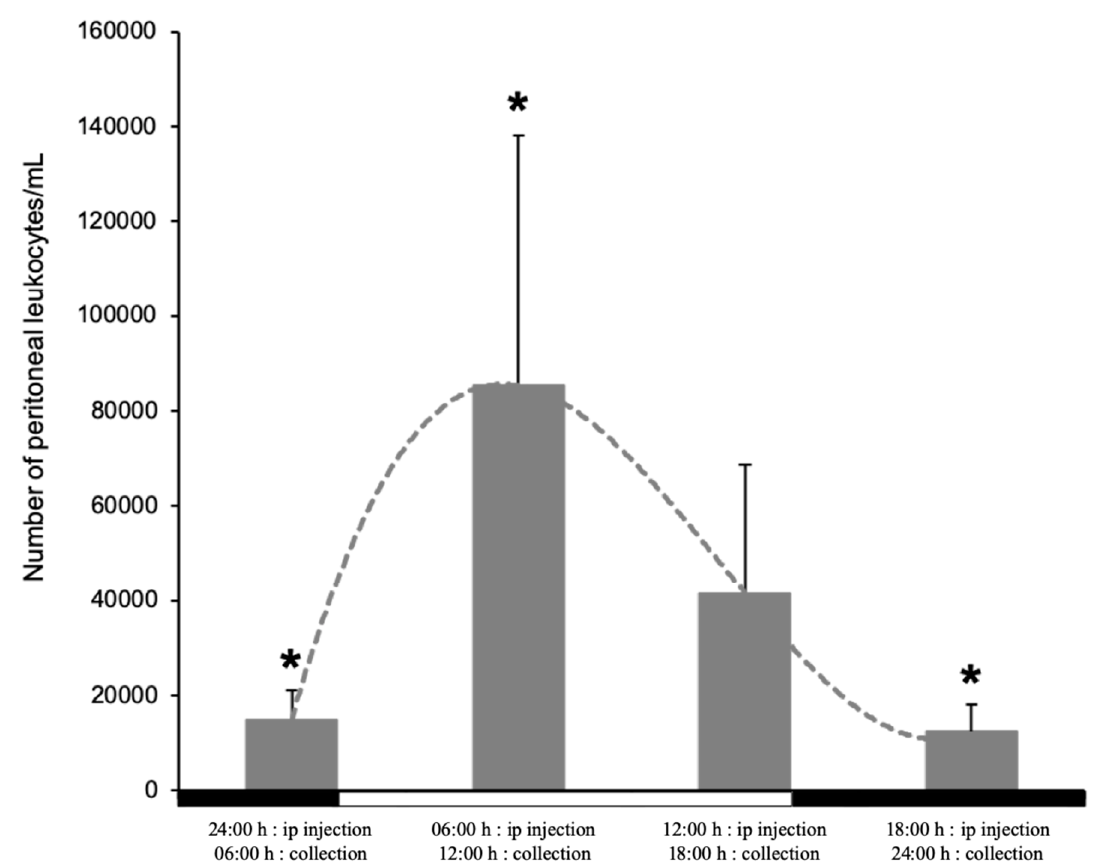
Figure 4. Number of leukocytes recruited to the peritoneal cavity within 6 h post-stimulation with inactivated A. salmonicida . Five fish per time point were used for the measurements; the number of cells was estimated from the peritoneal lavage using flow cytometry. Under each bar is detailed the time of the ip injection and the collection time of the peritoneal leukocytes. The data is presented as mean values with SD error bars. The statistical test used was one-way ANOVA with the Bonferroni post hoc test. Asterisks (*) represent statistical significance with p ≤ 0.05. The white and black bars on the x-axis represent the dark/light period.